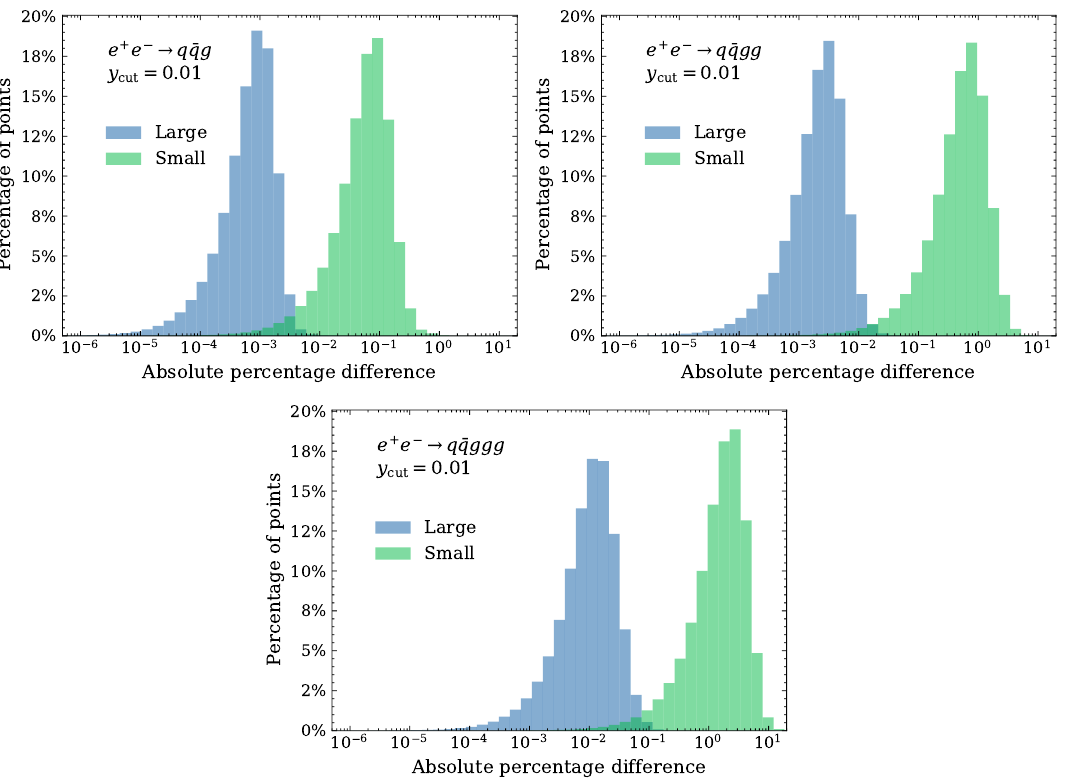
Figure 4 . Comparison of error distributions of 10 million matrix element predictions between NNs used in section 3.1 labelled as ‘Small’ and our larger NNs labelled as ‘Large’. Note that ‘small’ and ‘large’ NNs were trained on 500k and 40m training samples, respectively. The testing data is identical to those shown in figure 3, for the relevant global phase-space